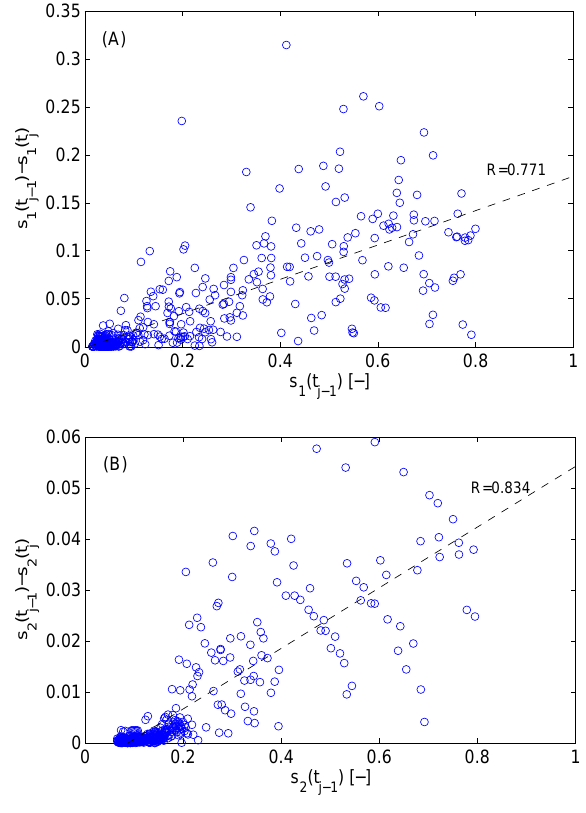
Fig. 4. Changes in relative soil saturation as a function of the relative saturation of the soil in the first (A) and second layer (B) . The graph has been derived from the time series of soil moisture at the station of Tondikiboro in